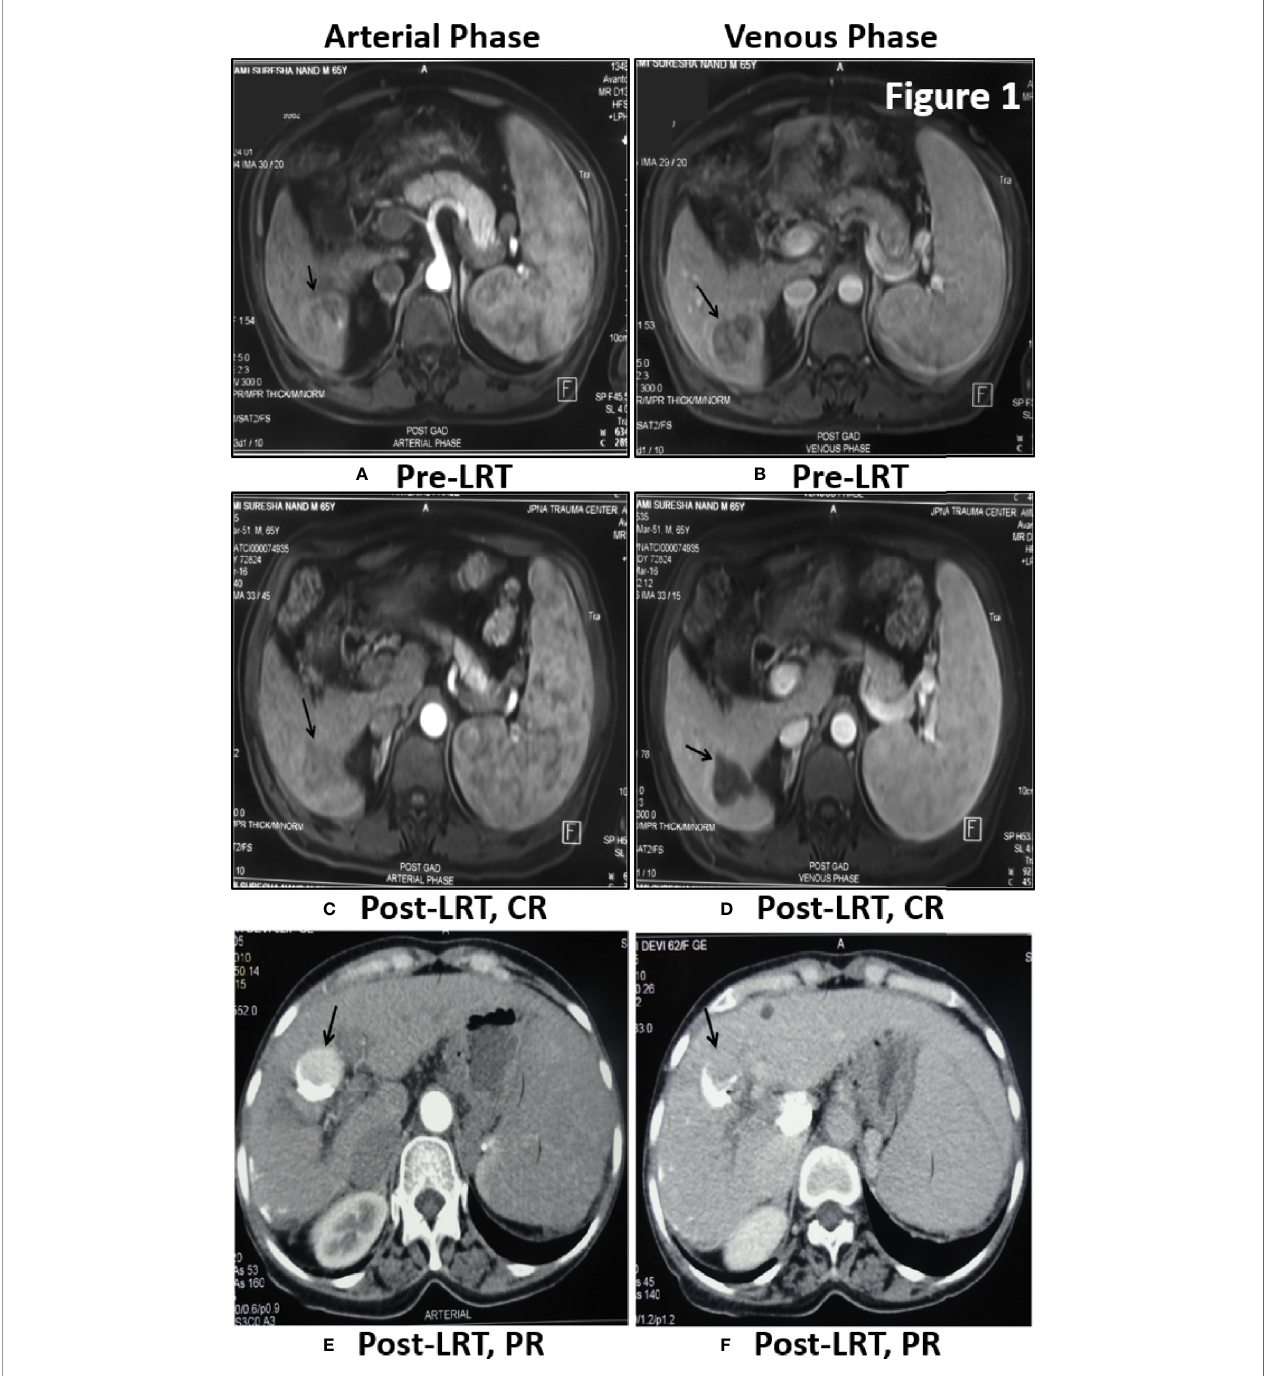
FIGURE 1 | Tumor response assessment by MPCT/MRI of Liver: Post-TACE MRI Scan of 65 yr old male patient of HBV- HCC have shown large solitary HCC in segment 6 showing enhancement in arterial phase (A) with washout in venous phase (B) before treatment. One month Post-LRT in MRI have shown lack of enhancement in treated tumor in arterial phase (C) and venous phase (D) is suggestive of Complete Response (CR). Post-TACE CT scan of 62 yr old female patient of HCV-HCC have shown residual enhancing tumor (black arrow) in arterial phase (E) with washout in venous phase (F) . Dense lipidol seen in the lateral aspect of tumor is suggestive of partial response to